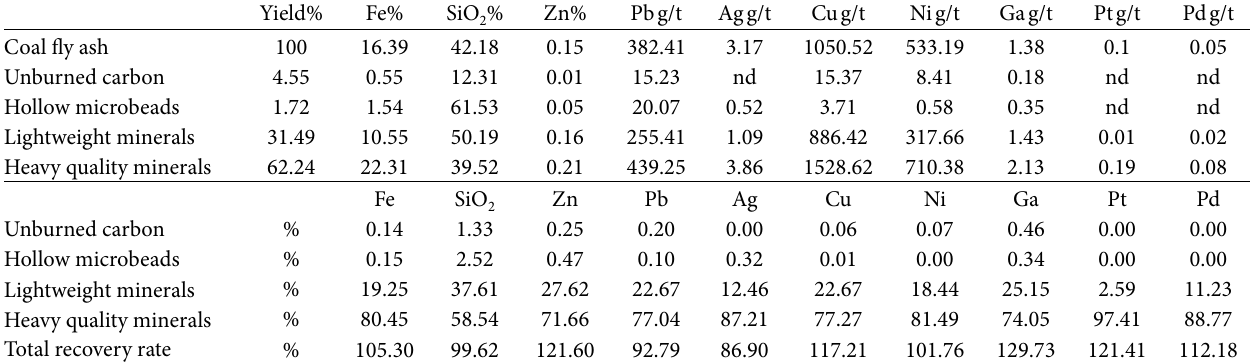
Table 4: Metal recovery tests of the fly